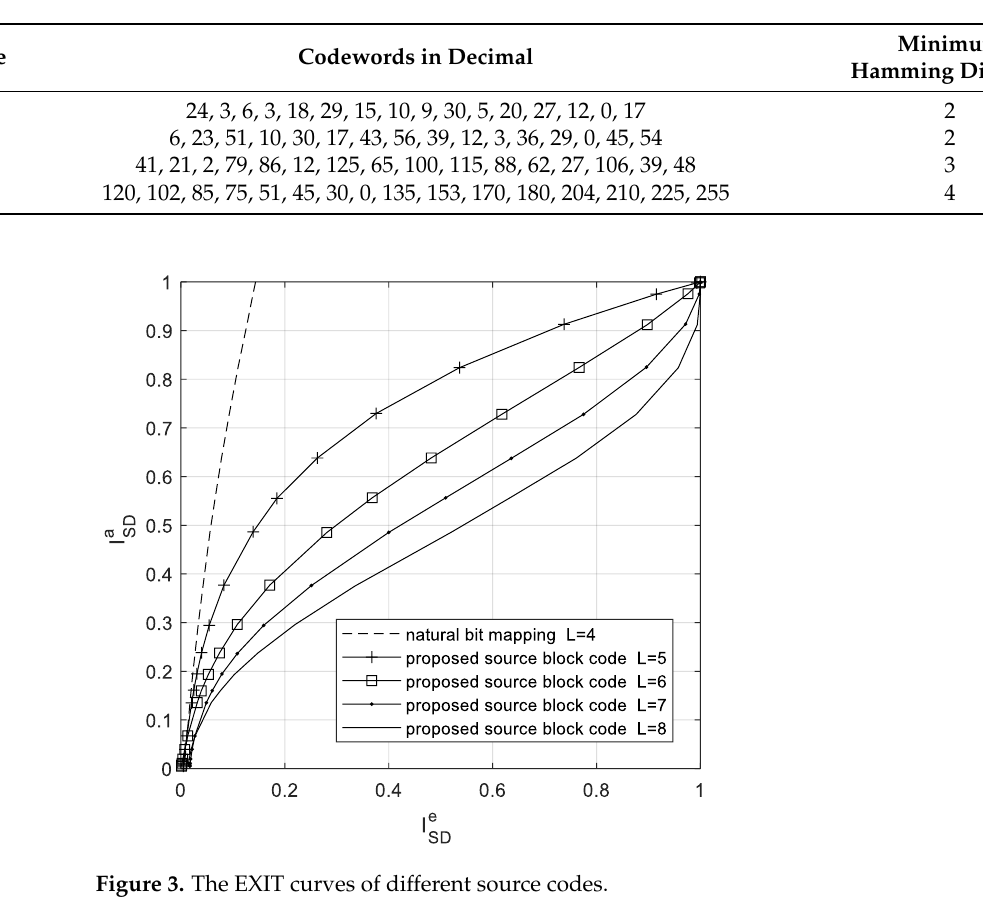
Table 1. Parameters of optimized source codewords with different code lengths.